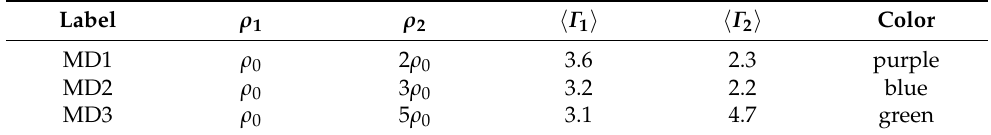
Table 1. Summary of the hyperparameters and averaged adjusted polytrope indices for piecewise EoS models. We employed 49 thousand EoS for each case. ρ 0 = 2.8 the nuclear saturation